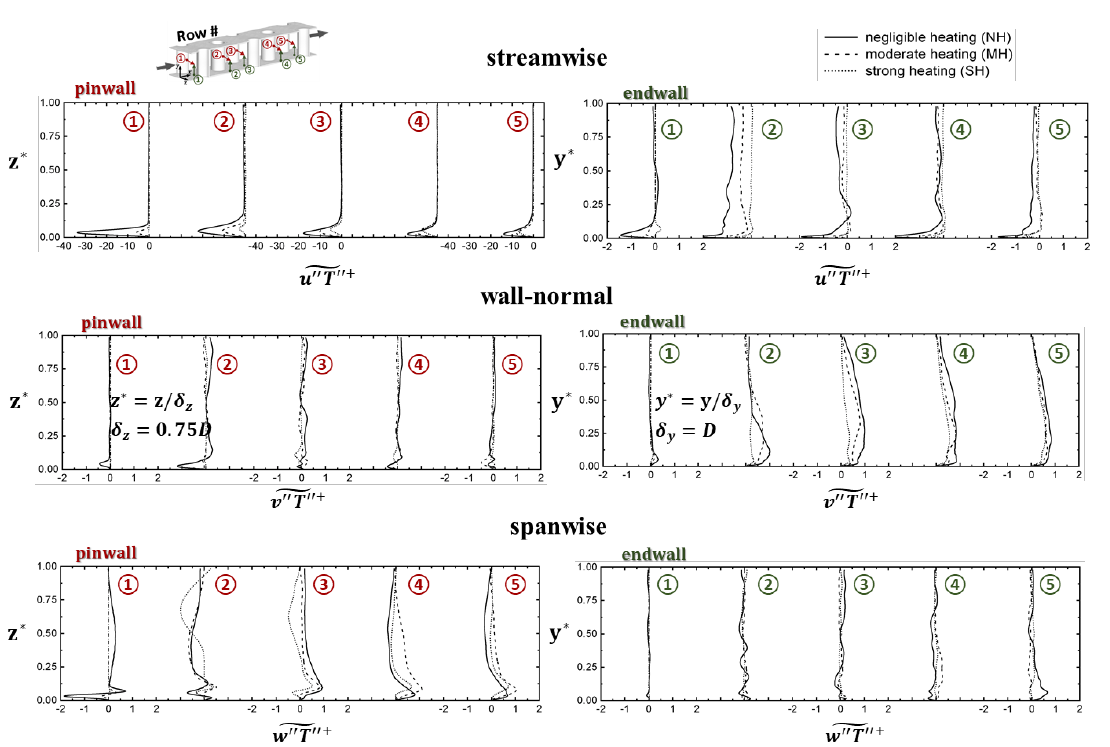
Figure 19. Resolved turbulent heat flux distributions for various heat loads.